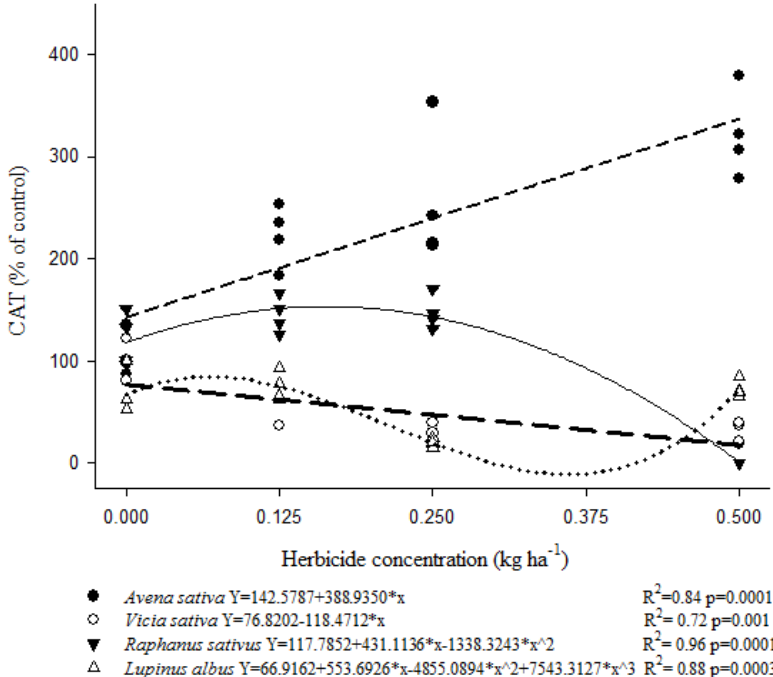
Figure 1 - Effect of fomesafen on catalase (CAT) activity in different crop